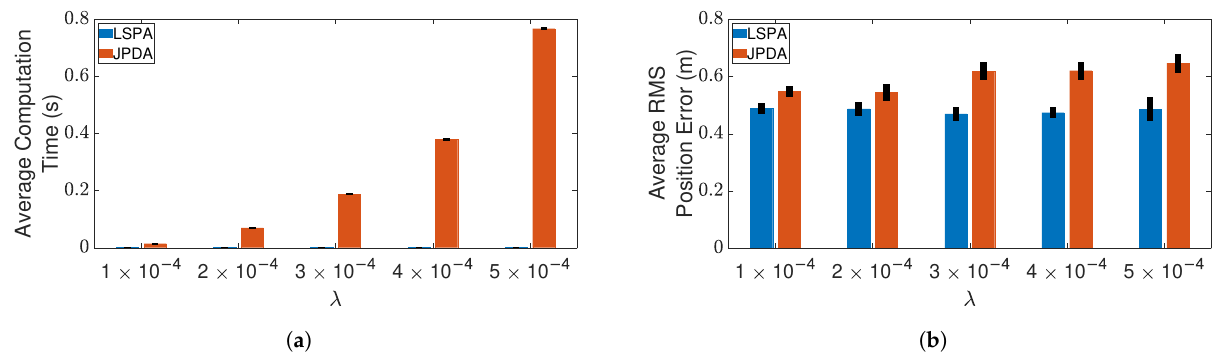
Figure 9. Tracking three crossing targets using LSPA and JPDA. ( a ) Average computation time for obtaining association probabilities; ( b ) average RMS position error. Error bars indicate 95% confidence intervals.